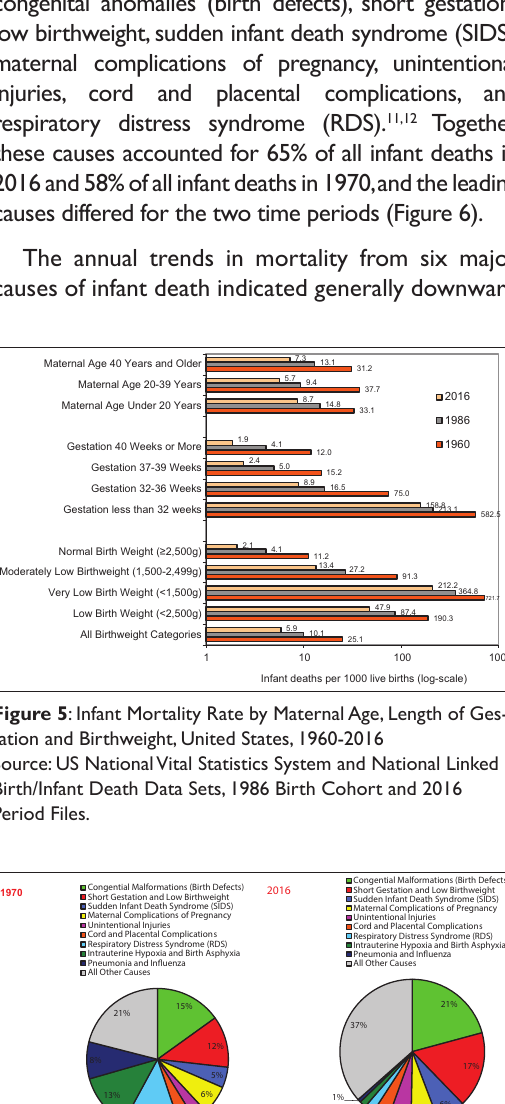
Figure 6 : Leading Causes of Infant Death: United States, 1970 and 2016 Source: US National Vital Statistics System.